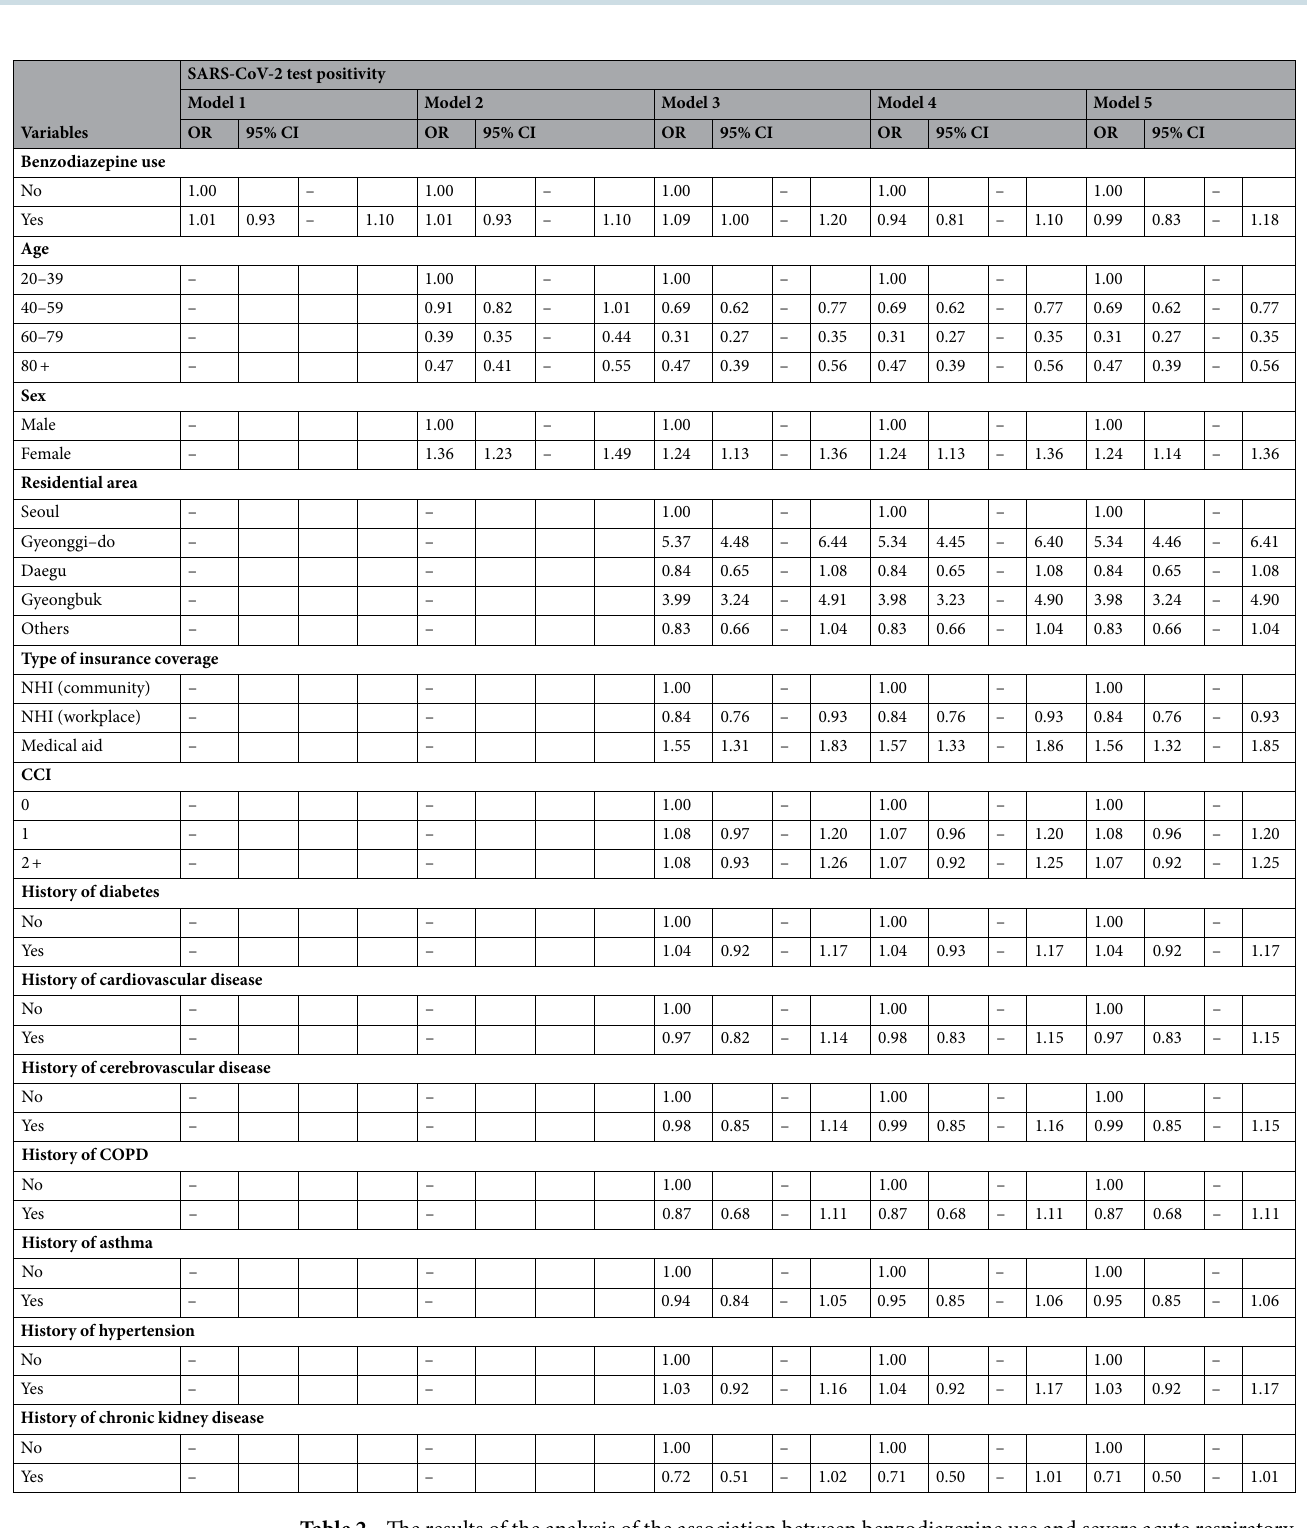
Table 2. The results of the analysis of the association between benzodiazepine use and severe acute respiratory syndrome coronavirus 2 (SARS-CoV-2) positivity after 1:1 propensity score matching. Model 1: crude model; Model 2: minimally adjusted; Model 3: fully adjusted; Model 4: chronic use of BZD for 90 days; Model 5: chronic use of BZD for 180 days. NHI National health insurance, CCI Charlson Comorbidity Index, COPD chronic obstructive pulmonary